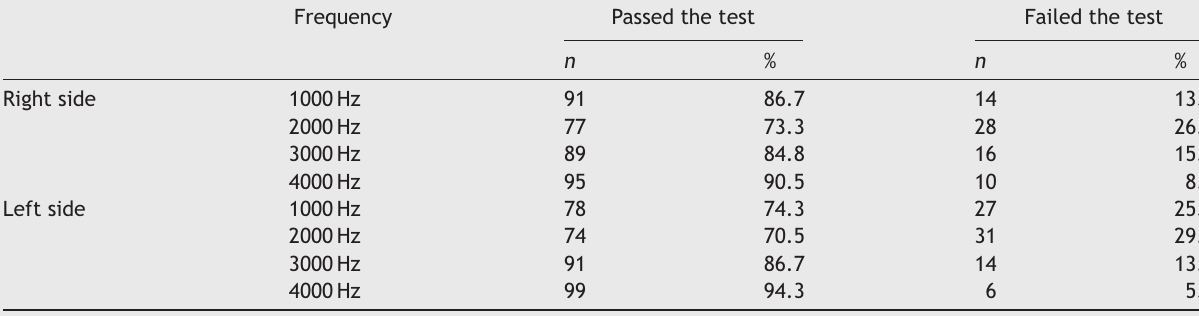
Description of power reflectance (PR) test in 105 newborns evaluated. Frequency